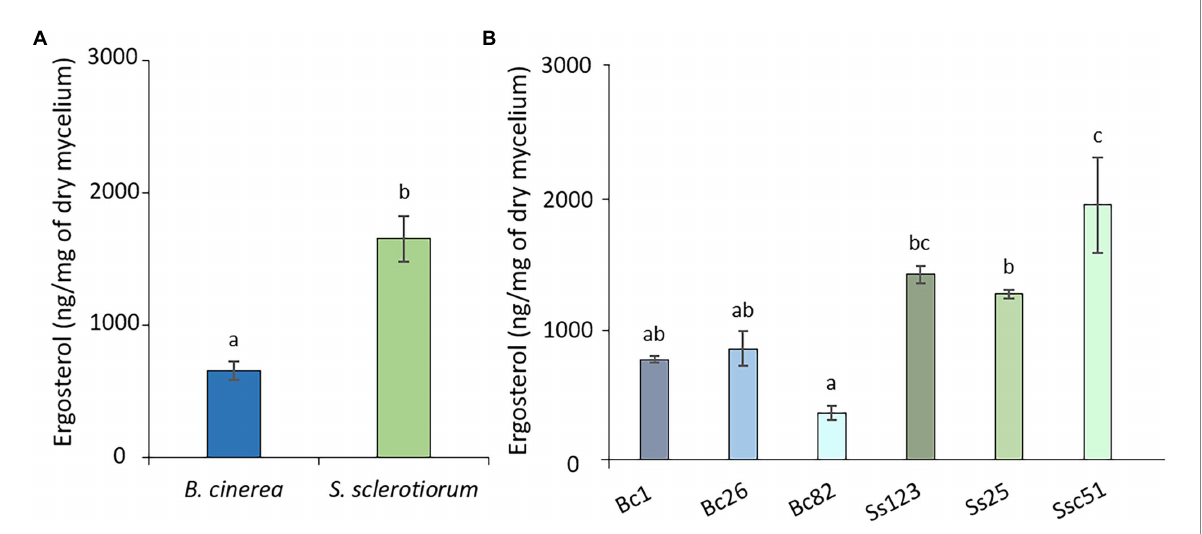
FIGURE 10 Ergosterol content of B. cinerea and S. sclerotiorum strains. Average ergosterol content of B. cinerea and S. sclerotiorum (means of 3 strains) (A) . Content of the different strains of B. cinerea (Bc1, Bc26, Bc82) and S. sclerotiorum (Ss123, Ss25, Ssc51) (B) . The height represents the mean value of at least 3 biological replicates. Error bars represent standard errors. Letters indicate significant differences ( p < 0.05) between the